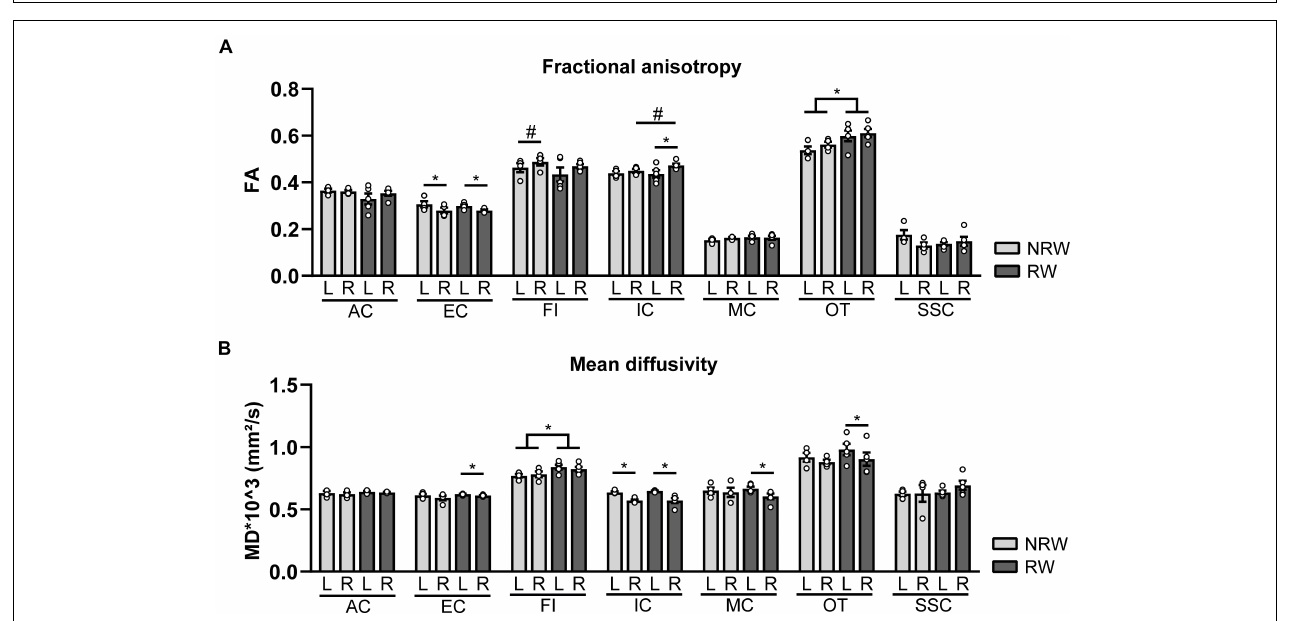
FIGURE 7 | Diffusion tensor imaging (DTI) measures assessed at 1 week post-surgery in running wheel (RW) and no running wheel (NRW) animals. (A) Fractional anisotropy (FA) and (B) mean diffusivity (MD) were assessed in different ROI (AC: anterior commissure, EC: external capsule, FI: fimbria, IC: internal capsule, MC: motor cortex, OT: optic tract, SSC: somatosensory cortex) in the ipsilateral (R: right) contralateral (L: left) hemisphere. RW: N = 5, NRW: N = 4; values represented in mean ± SEM. # 0.05 < p < 0.08 (tendency); * p ≤ 0.05.